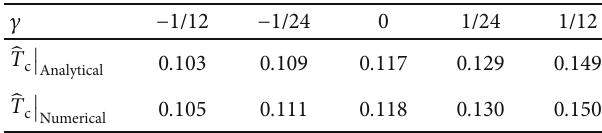
Table 1: The analytical and numerical results for the critical temperature of the holographic superconductors from the 4-derivative theory.